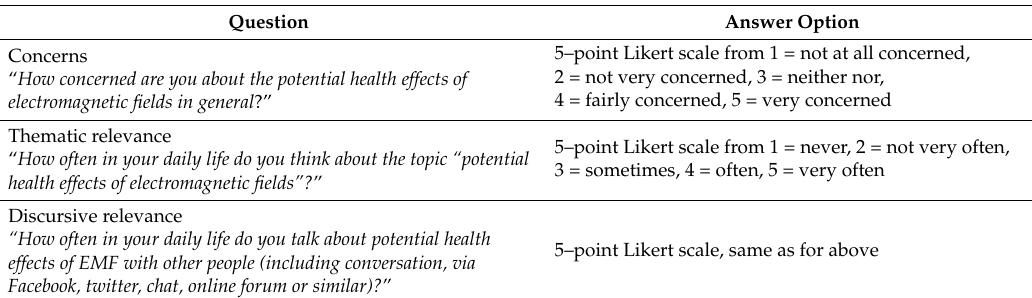
Table 1. Questions on risk perception of electromagnetic fields (EMFs) in general and thematic and discursive